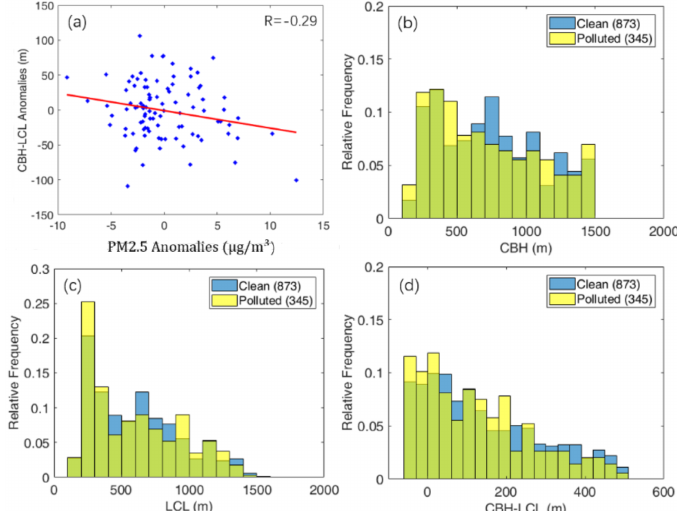
Figure 8. ( a ) The relationship between CBL–LCL and PM 2.5 ; ( b ) distribution of cloud base height; ( c ) distribution of lifting condensation level; and ( d ) distribution of CBH–LCL. The number in the parentheses in ( b – d ) is the number of cloud cases. The light-green color shows overlap in the relative frequencies for the clean and polluted aerosol